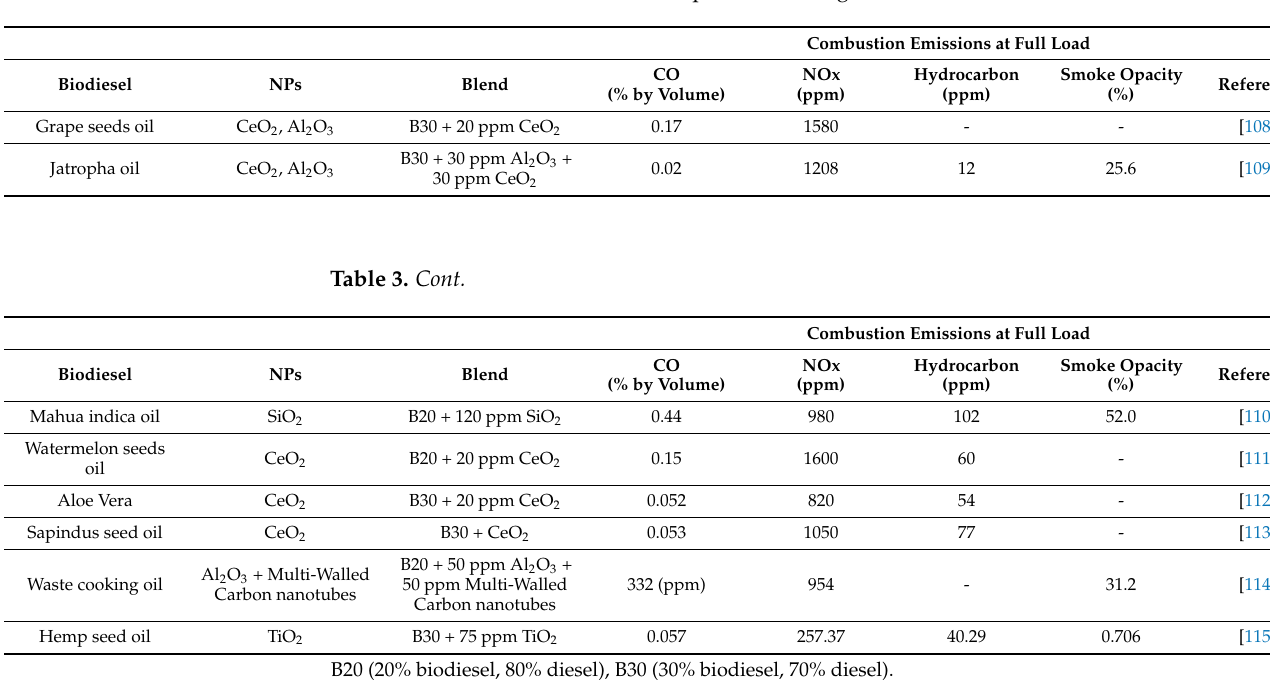
Table 3. The effects of different nanoparticles on engine emissions.